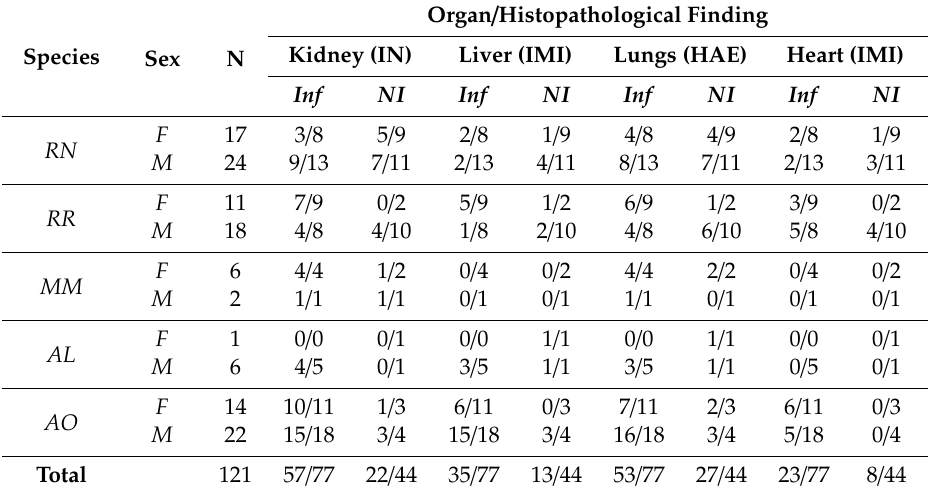
Table 7. Infection status by pathogenic Leptospira and histopathological findings by species and sex in rodents trapped in dairy farms in the Los R í os Region, Chile.